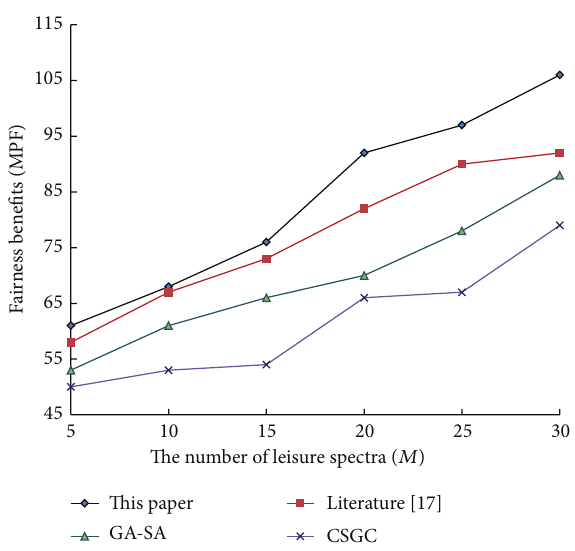
Figure 3: Influence of leisure spectrum on MPF.